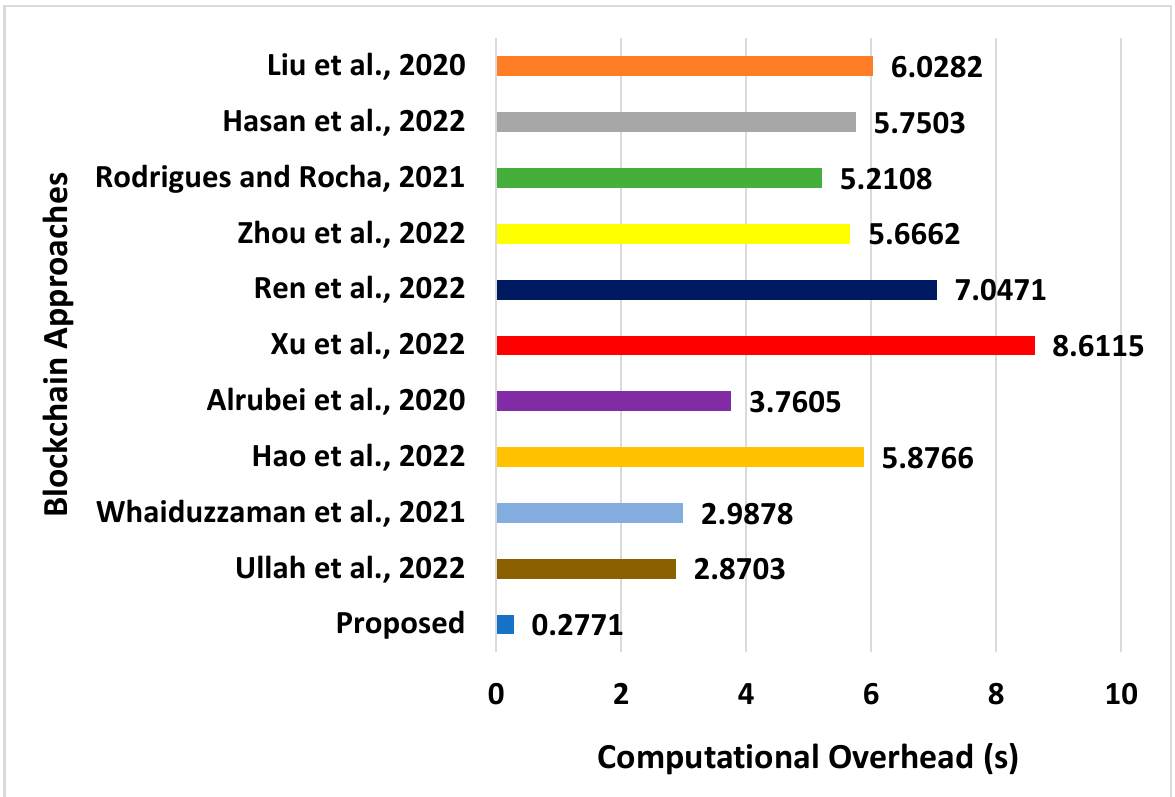
Figure 5. Analysis of computational overhead [39–48].